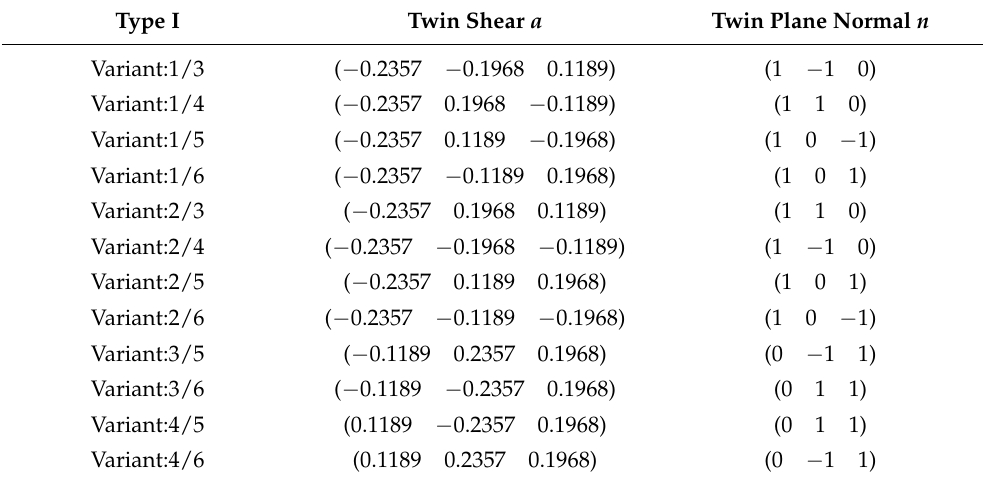
Table 3. Twin elements for type I twins with different variant